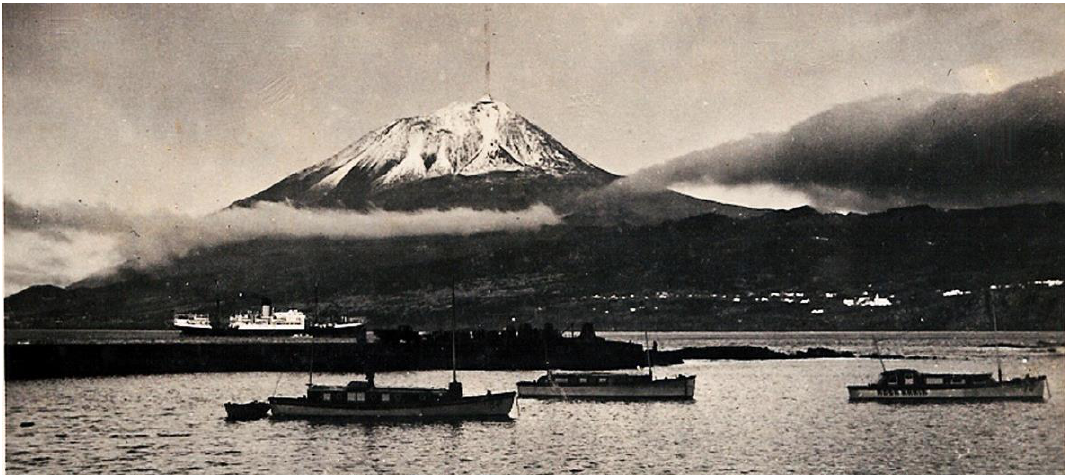
Figure 3. View of the volcano from the Lajes bay. Source: Arquivo de Villa Maria, Terceira ,